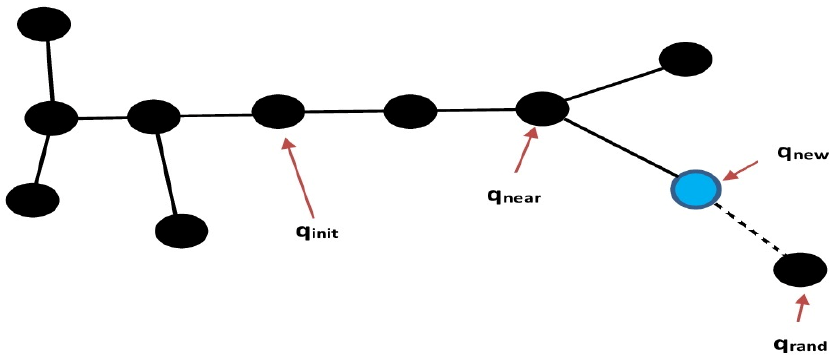
Figure 15. Representation of RRT algorithm for the path planning of mobile